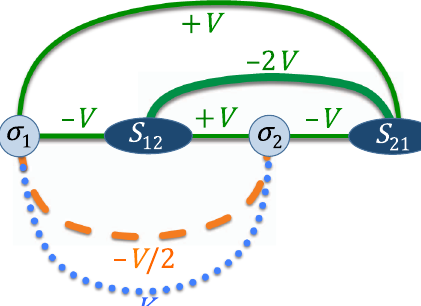
FIG. 8. Setup for the minimal implementation using four ions. Spin-spin interactions are created by pairs of Raman beams, as ¼ 2(cid:3) . By tuning close explained in Fig. 3, with strengths (cid:3) S (cid:5) ¼ characterized by amplitudes M to the vibrational mode q nq 0 0 ð 1 ; (cid:1) 1 ; (cid:1) 1 ; 1 Þ = 2 , one obtains zz spin-spin couplings, as desired n [Eq. (10)] (green solid lines). An additional undesired, for ~ H G weaker interaction (orange dashed line) does not affect the system dynamics. Mediated by a different vibrational mode, an additional laser pair generates the xx interaction, as required for H (blue dotted K